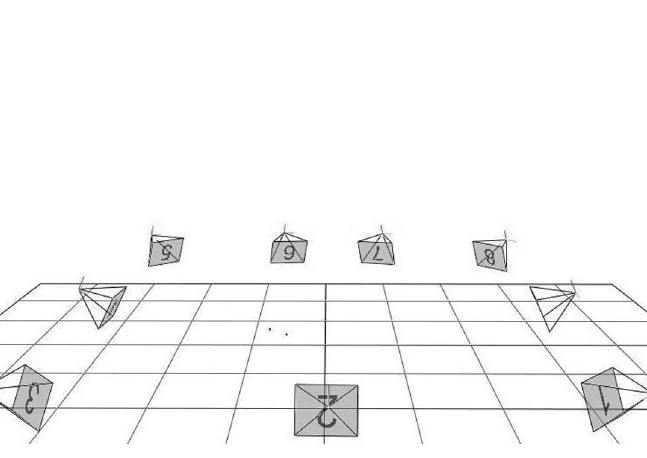
Fig. 4. Videogrammetry cameras are set up around the room’s perimeter and track body motion.